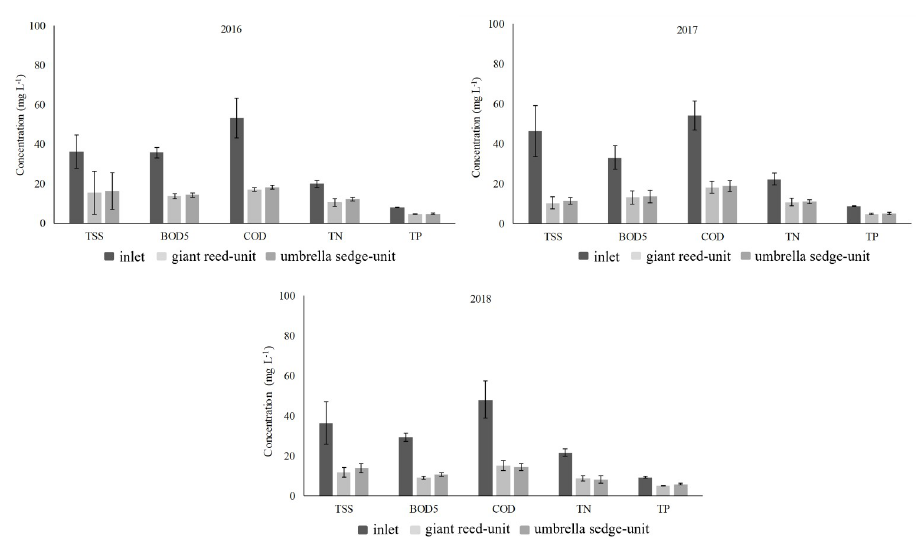
Fig 2. Average concentrations for chemical parameters at the HSSFs CW inlet and outlet in 2016, 2017 and 2018. Bars represent standard deviation.